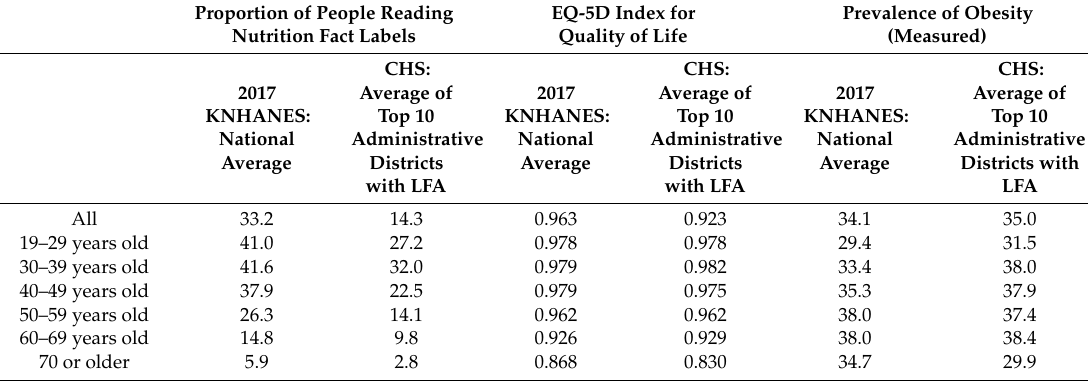
Table 11. Proportion of people reading nutrition fact label, quality of life index, prevalence of obesity by age